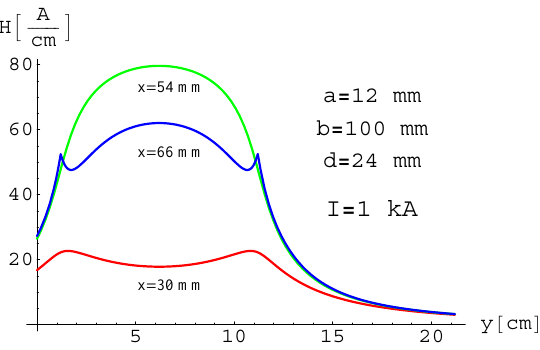
Figure 9. The distribution of magnetic field intensity along the line y = const (constants) of an unshielded busbar system with current symmetry.